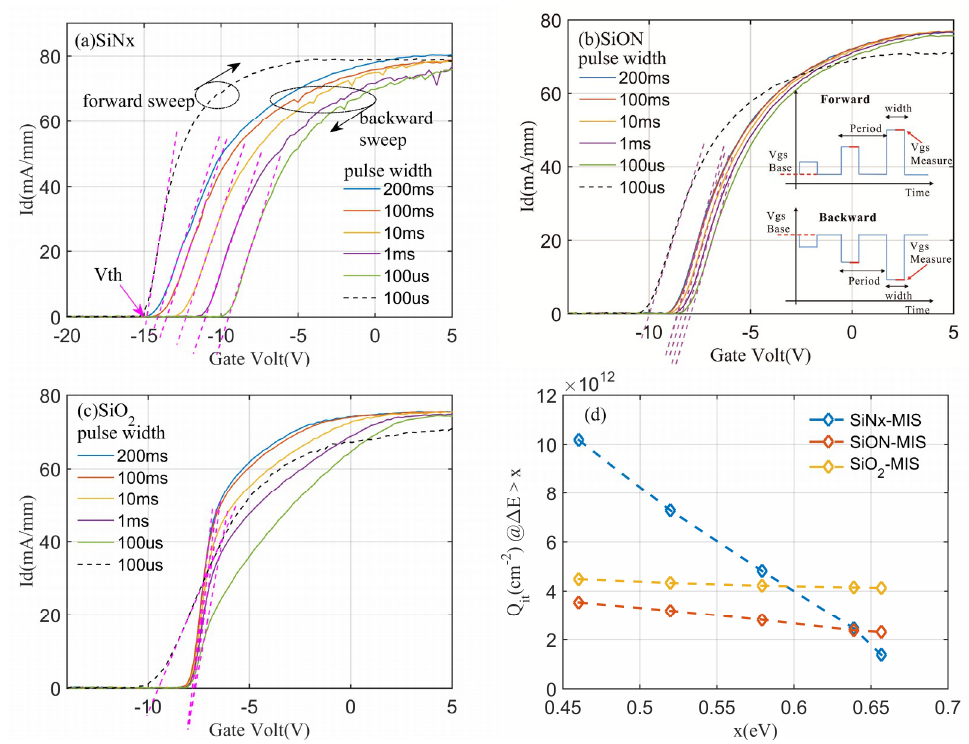
Figure 5. Pulse mode Id-Vgs curves with pulse width variations of 100 μs, 1 ms, 10 ms, 100 ms, and 200 ms. The pulse period is 500 ms. The Vds was kept at 1 VThe backward Vgs base is 5 V. ( a ) SiNx MIS-HEMT with forward Vgs base of −20 V ( b ) SiON MIS-HEMT with forward Vgs base of −14 V. Inset: pulse Vgs condition with forward sweep and backward sweep ( c ) SiO 2 MIS-HEMT with forward Vgs base of −14 V ( d ) Interface trap charge density Q it at ∆E > x(eV) of three samples.